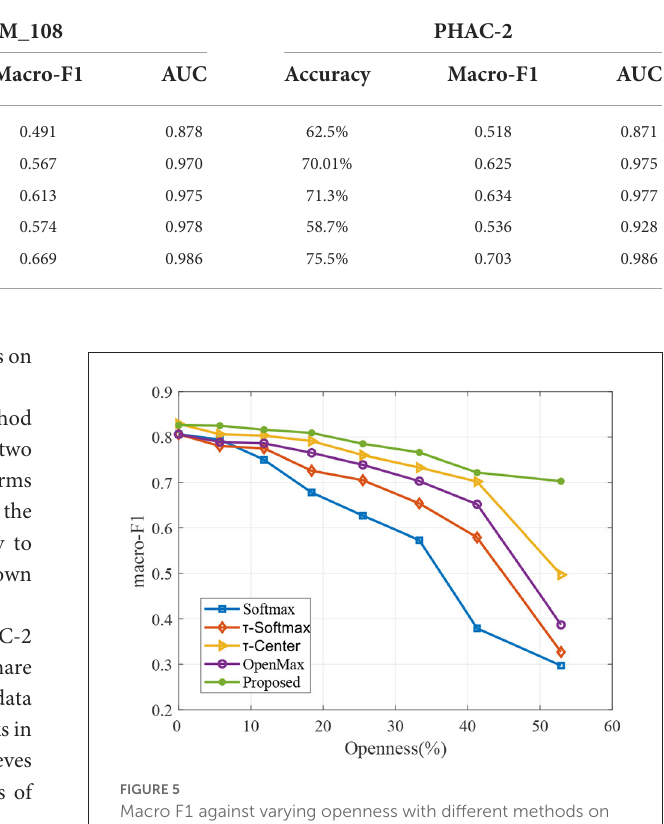
TABLE 3 Experimental results of different method.